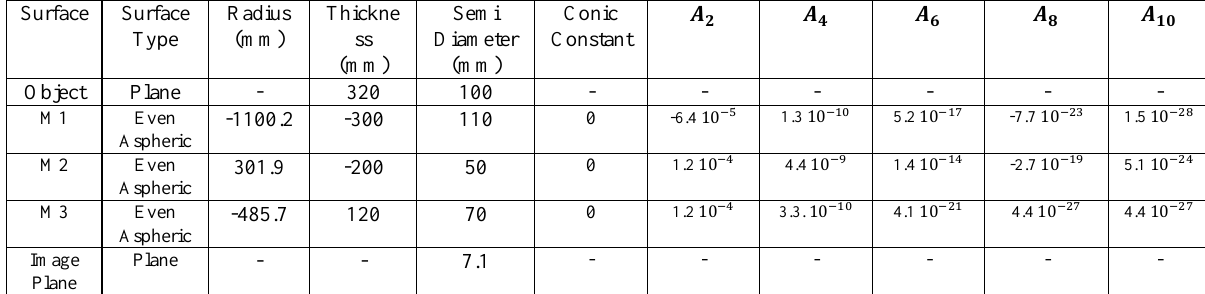
Table 6 . Optical prescription of the TMA telescope design